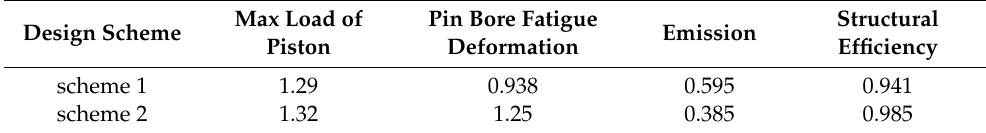
Table 3. Comparison of piston structure efficiency under the two